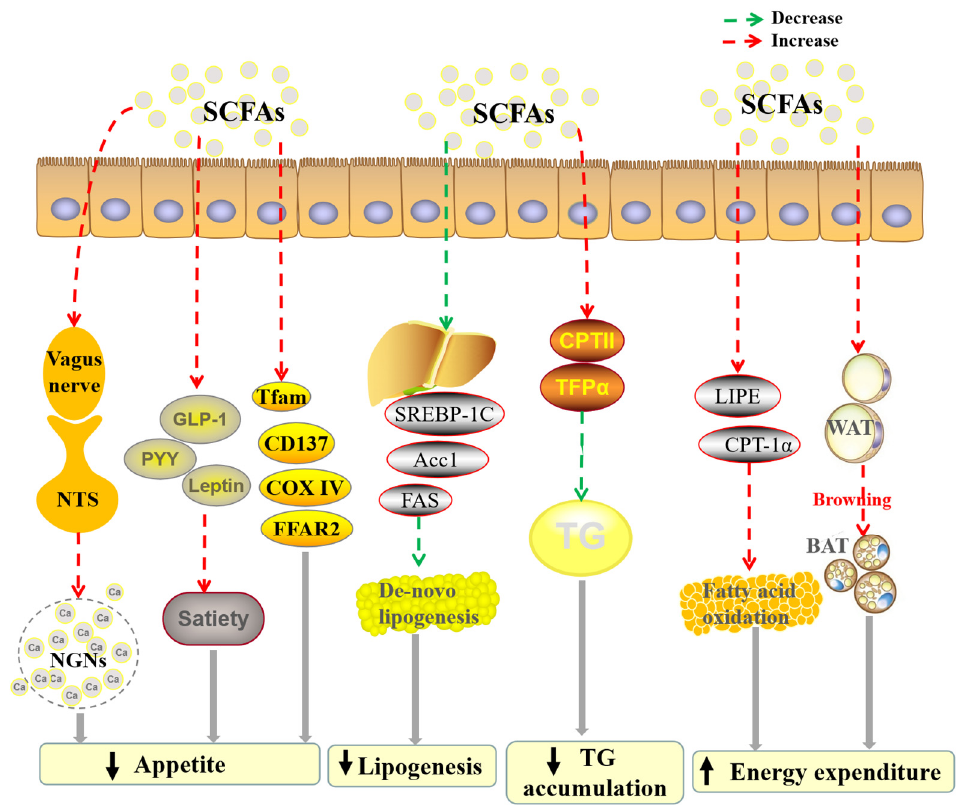
Figure 3. The main effects and mechanisms of SCFAs on obesity. ↓ represents decrease, and ↑ represents increase. Abbreviation: Acc1, acetyl-CoA carboxylase-1; BAT, brown adipose tissue; CD137, tumor necrosis factor receptor superfamily member 9; COX IV, cytochrome-C oxidase IV; CPT, carnitine palmitoyl transferase; FAS, fatty acid synthase; FFAR2, free fatty acid receptor 2; GLP-1, glucagon-like peptide 1; LIPE, lipase hormone sensitive; NTS, nucleus tractus solitaries; PYY, peptide YY; SCFA, short-chain fatty acid; SREBP-1C, sterol-regulatory element-binding pro- tein 1C; Tfam, mitochondrial transcription factor A; TFP α , trifunctional protein alpha; WAT, white adipose